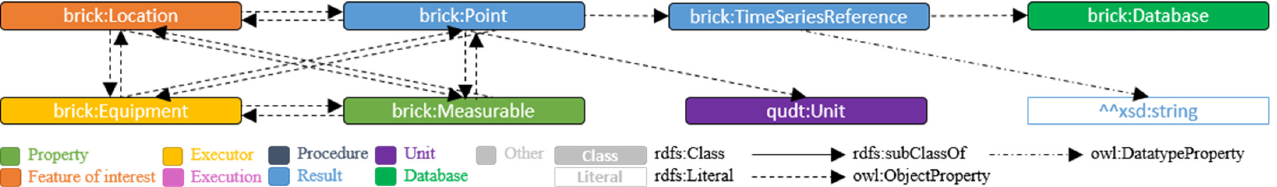
Figure 17. Brick’s pattern for describing time-series data that is stored in an external database.